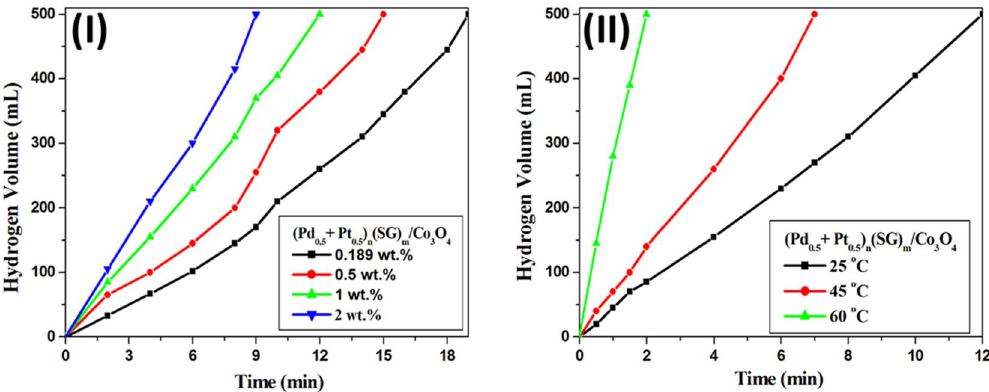
Figure 8. ( I ) Effect of NaBH 4 amount for hydrogen generation over 1 wt.% (Pd 0.5 –Pt 0.5 ) n (SG) m /Co 3 O 4 . Reaction conditions: 0.189, 0.5, 1 and 2 g NaBH 4 amount in 100 H 2 O; Catalyst, 5 mg; at 25 °C. ( II ) Effect of reaction temperature for hydrogen generation from the hydrolysis of NaBH 4 over 1 wt.% (Pd 0.5 –Pt 0.5 ) n (SG) m /Co 3 O 4 . Reaction conditions: 1 g of NaBH 4 in 100 H 2 O; catalyst, 5 mg; at 25–60